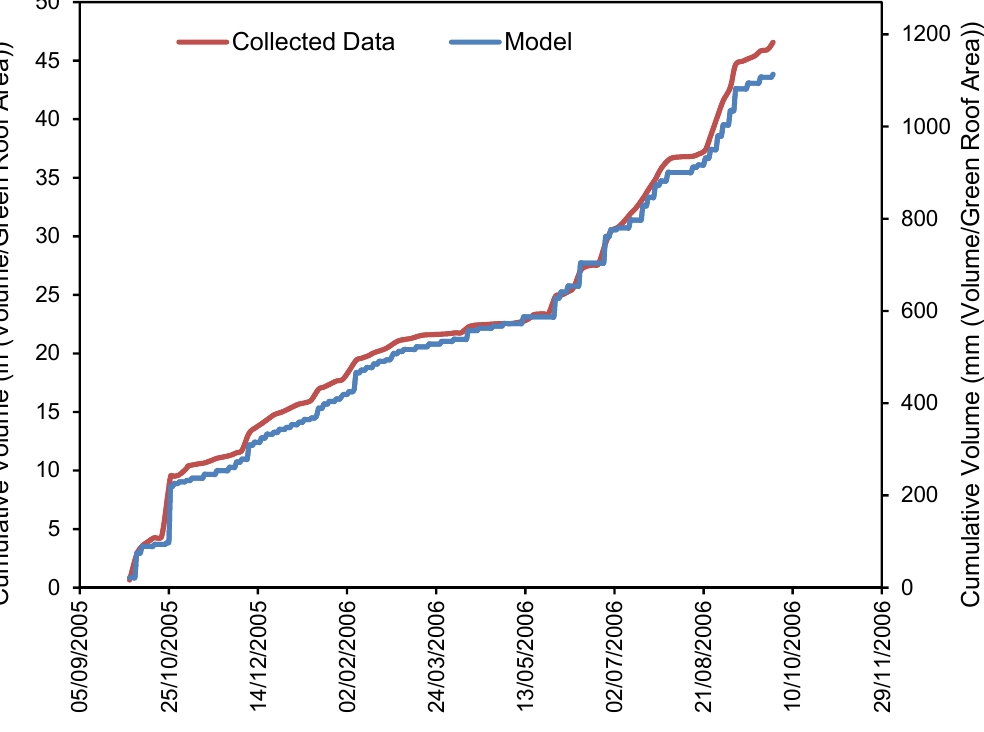
Figure 7. Cumulative filtrate volume vs . time for modeled data and a full sized green roof data from Hardin and Wanielista